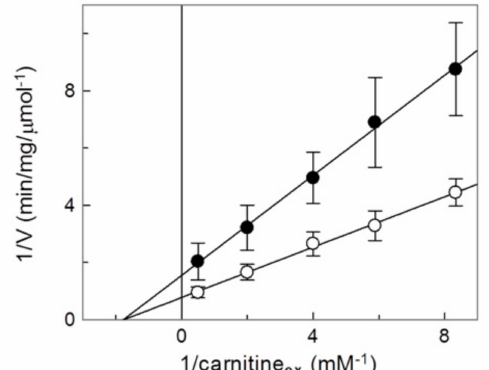
Figure 4. Kinetic analysis of the inhibition by Cu 2 + of the recombinant CAC. The carnitine / carnitine antiport rate was measured, as described in Materials and Methods, adding [ 3 H]carnitine at the indicated concentrations to proteoliposomes containing 15 mM internal carnitine in the absence (